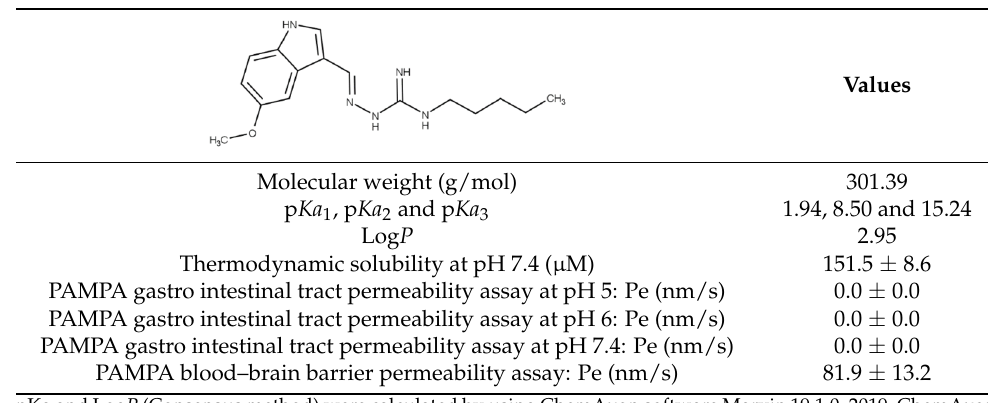
Table 3. Physicochemical and permeability data concerning tegaserod.